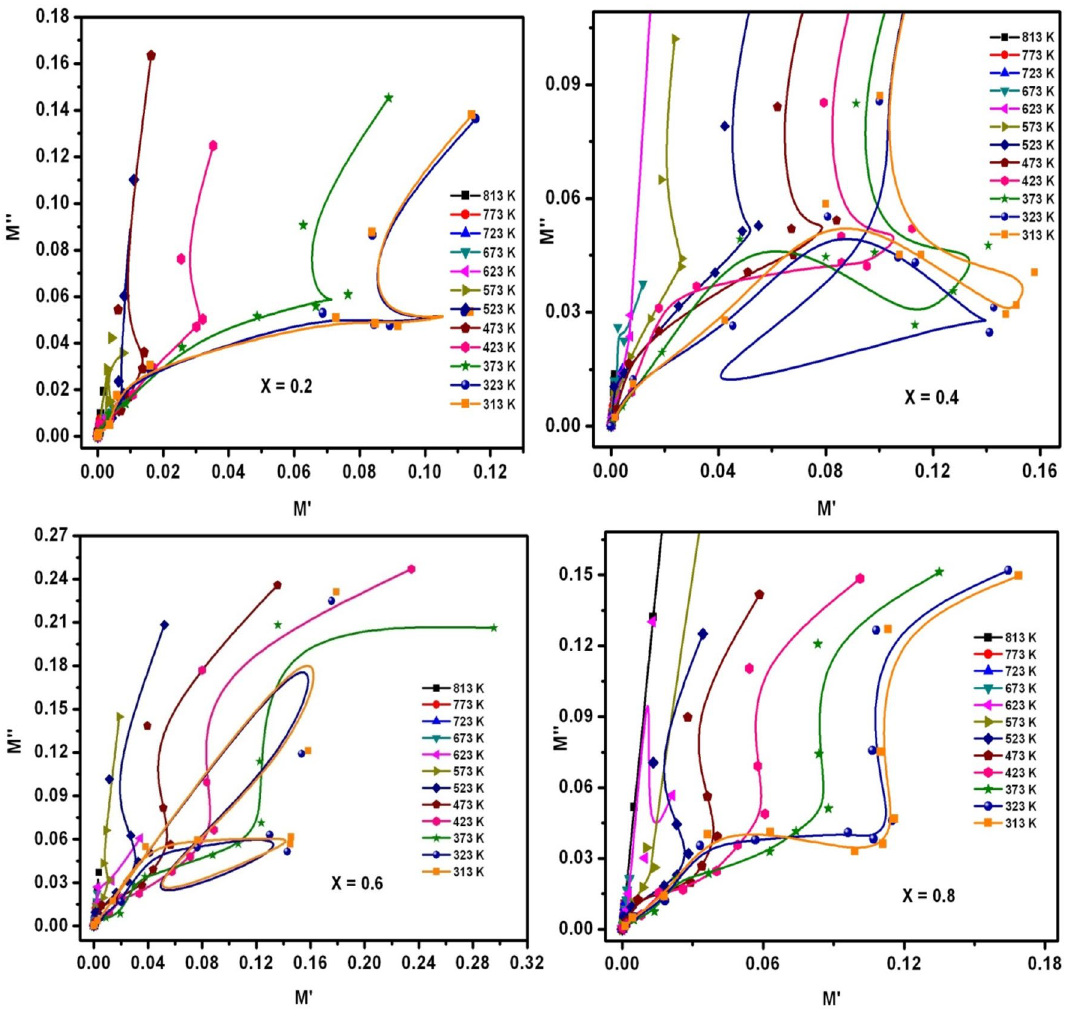
Figure 18. M ′ versus M ″ versus log f plots of SLFO